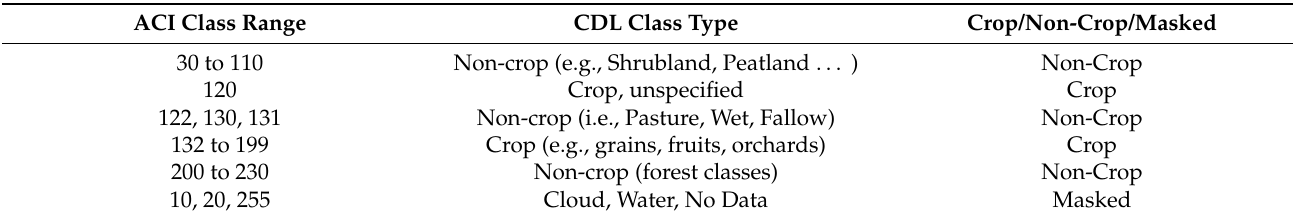
Table 1. Aggregation scheme used for re-classifying the 2019 AAFC Annual Crop Inventory into binary crop/non-crop grids (Figure 1b).